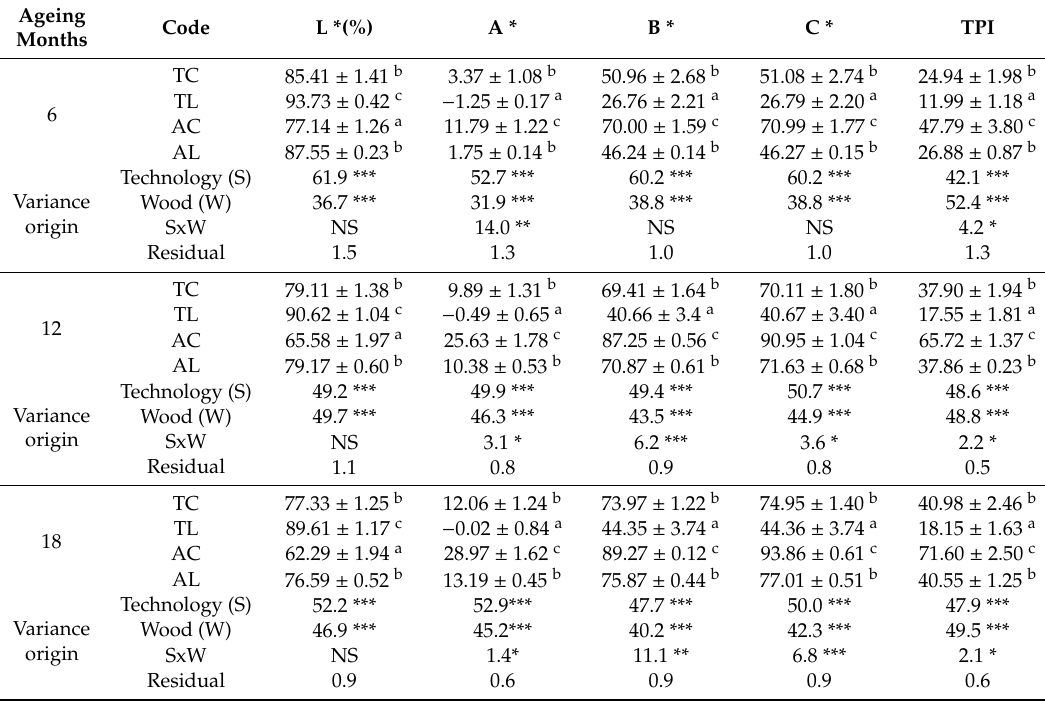
Table 1. E ff ect of the ageing technology and kind of wood on the chromatic characteristics and total phenolic index acquired by the wine spirits after 6, 12, and 18 months of ageing. AC: Alternative Chestnut, AL: Alternative Oak, TC: Traditional Chestnut, TL: Traditional